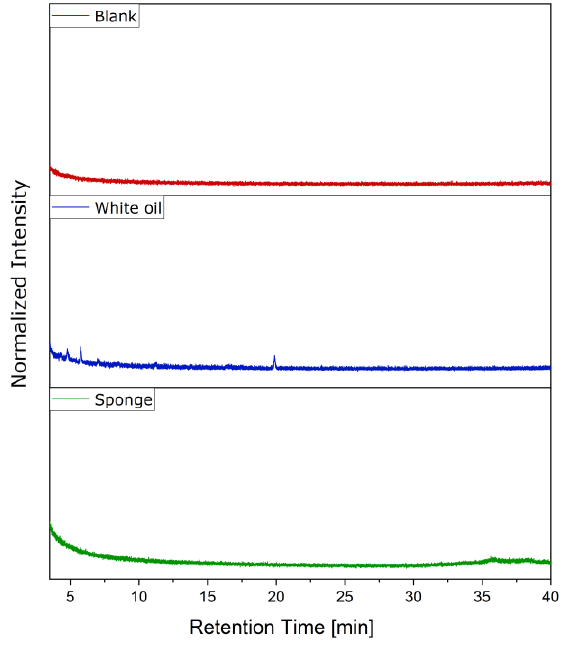
Figure A1. SHS/GC-MS total ion chromatograms of the blank measurement, white oil, and sponge.